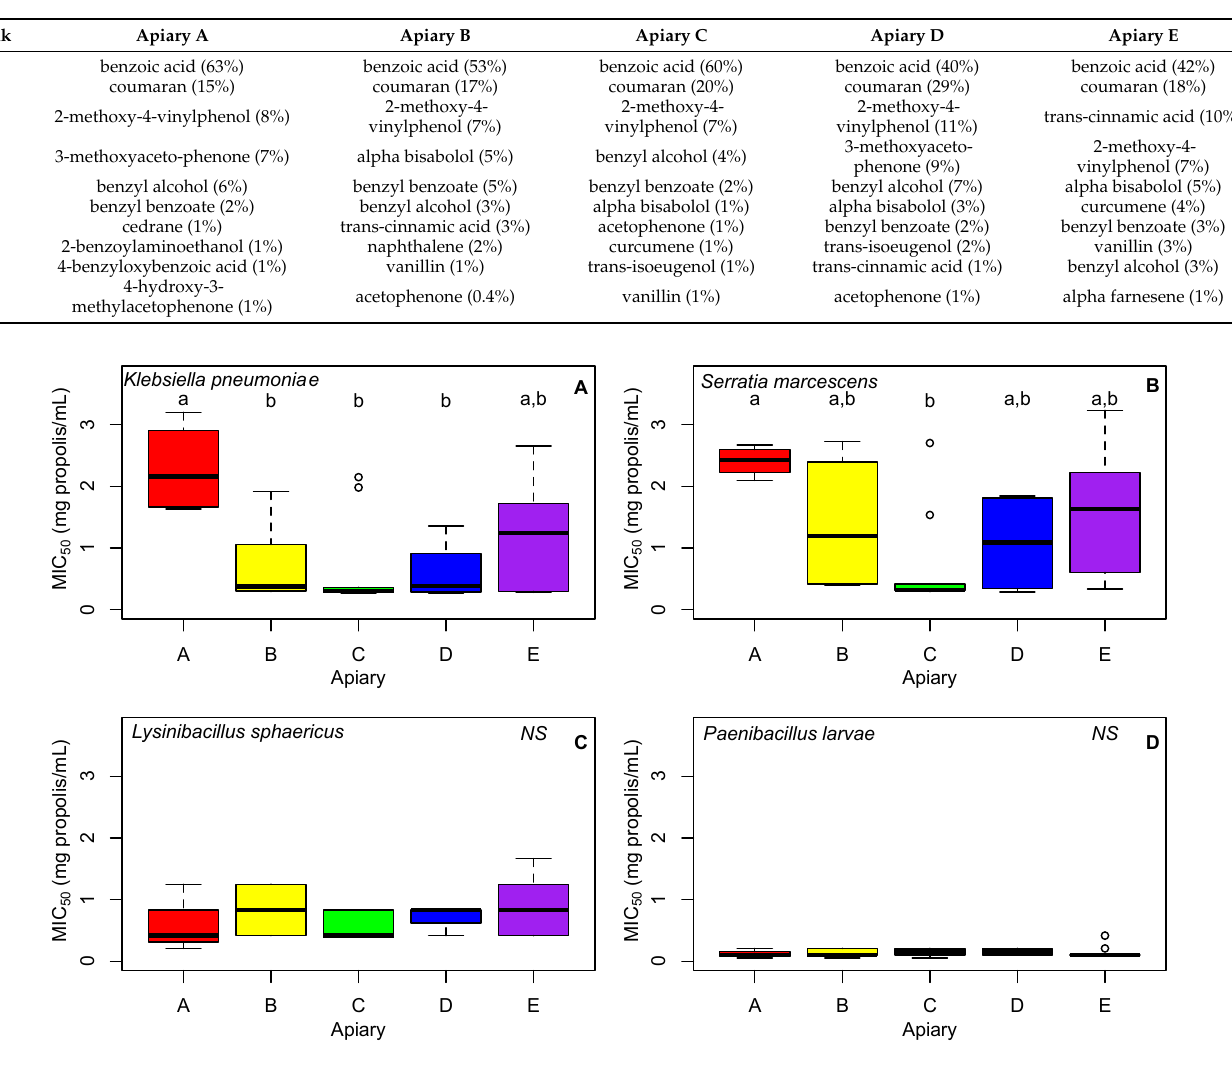
Figure 3. Box plot of MIC 50 values of propolis samples for four honey bee pathogens, K. pneumoniae ( A ), S. marcescens ( B ), L. sphaericus ( C ), and P. larvae ( D ). Apiaries are represented by letter (A–E). Boxes not sharing the same letter superscript are significantly different from each other ( p <